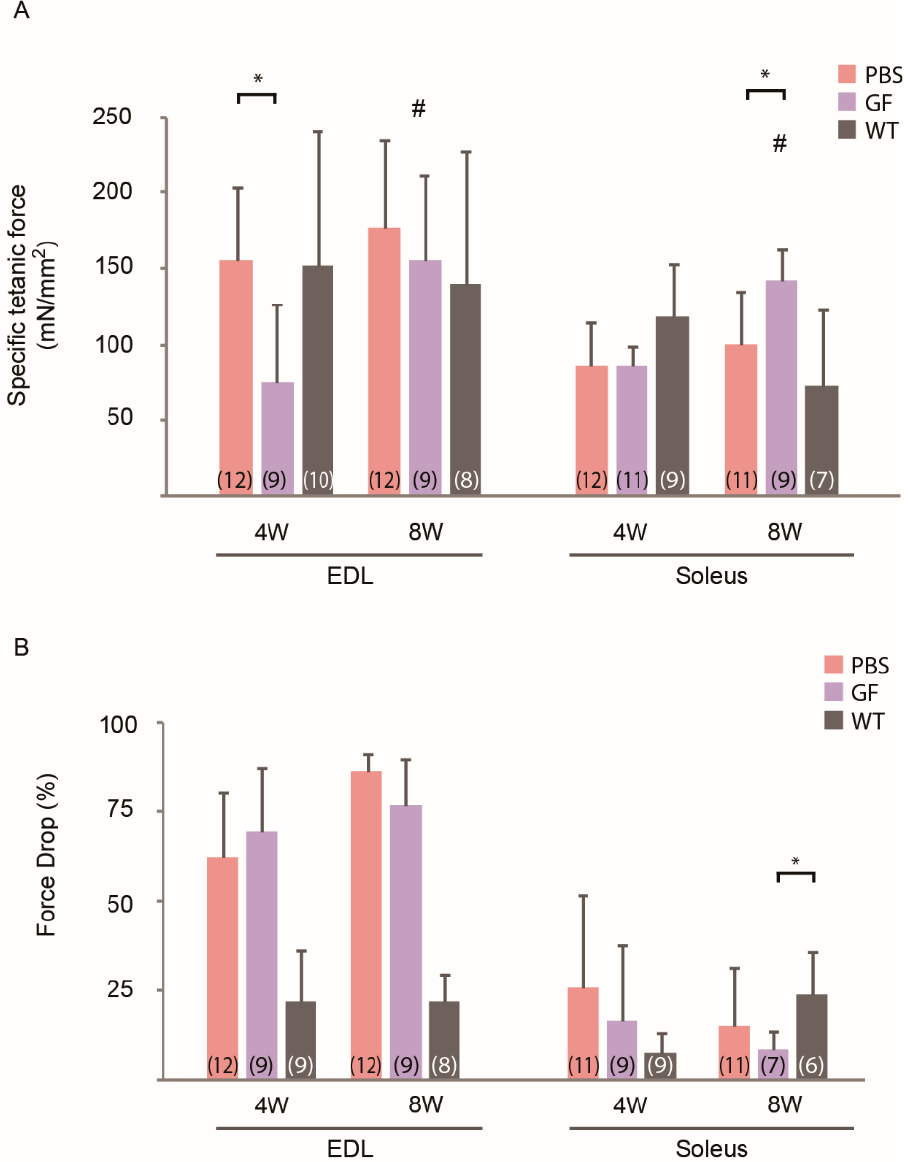
Figure 5. Ex vivo specific tetanic force and force drop in EDL and soleus of mdx treated for 12 weeks with growth factors. ( A ) Specific force of tetanic contraction in EDL and soleus of 4W and 8W mdx . ( B ) Force drop in muscles subjected to a stretch protocol. N is showed in the table in parentheses and may vary due to non-responsiveness to stimuli or loss of connection to the force transducer during the protocol. EDL, m. extensor digitorum longus; GF, growth factor; PBS, phosphate-buffered saline; WT, wild-type strain. Data presented as mean and vertical bars representing SD. Two-way ANOVAs were performed with subsequent Tukey HSD post-hoc tests to assess significance. Horizontal bars indicate significance: *: p < 0.05, #: p < 0.05 vs. 4W